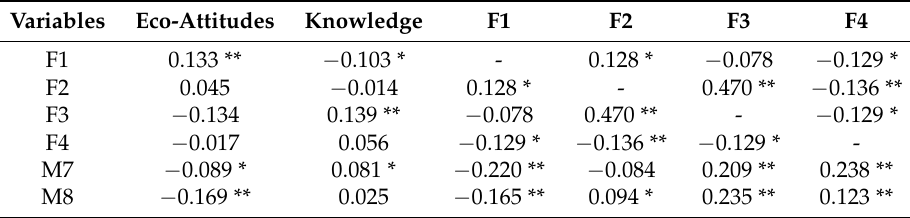
Table 5. The results of tests of pairwise association between the stages (F1–F4) and determinants of willingness to energy monitoring (note: ** p < 0.01 and * p < 0.05). Variables Eco-Attitudes Knowledge F1 F2 F3 F4 F1 0.133 ** − 0.103 * - 0.128 * − 0.078 − 0.129 * F2 0.045 − 0.014 0.128 * - 0.470 ** − 0.136 ** F3 − 0.134 0.139 ** − 0.017 0.056 − 0.136 ** − 0.129 * - M7 − 0.089 * 0.081 * − 0.220 ** − 0.084 0.209 ** 0.238 ** M8 − 0.169 ** 0.025 − 0.165 ** 0.123